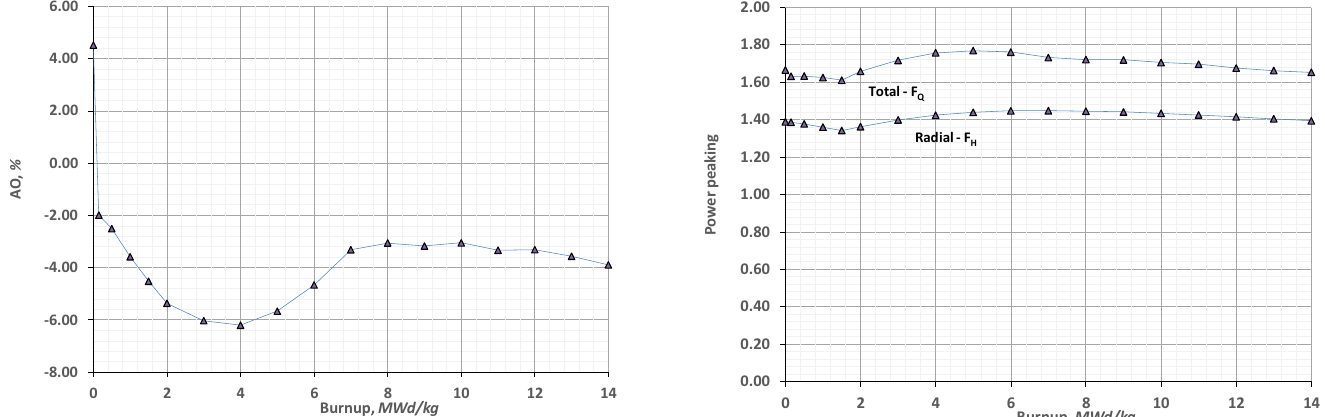
Fig. 10. Axial Offset (AO) (left) and radial and total power peaking factors (right) for I 2 S-LWR calculated